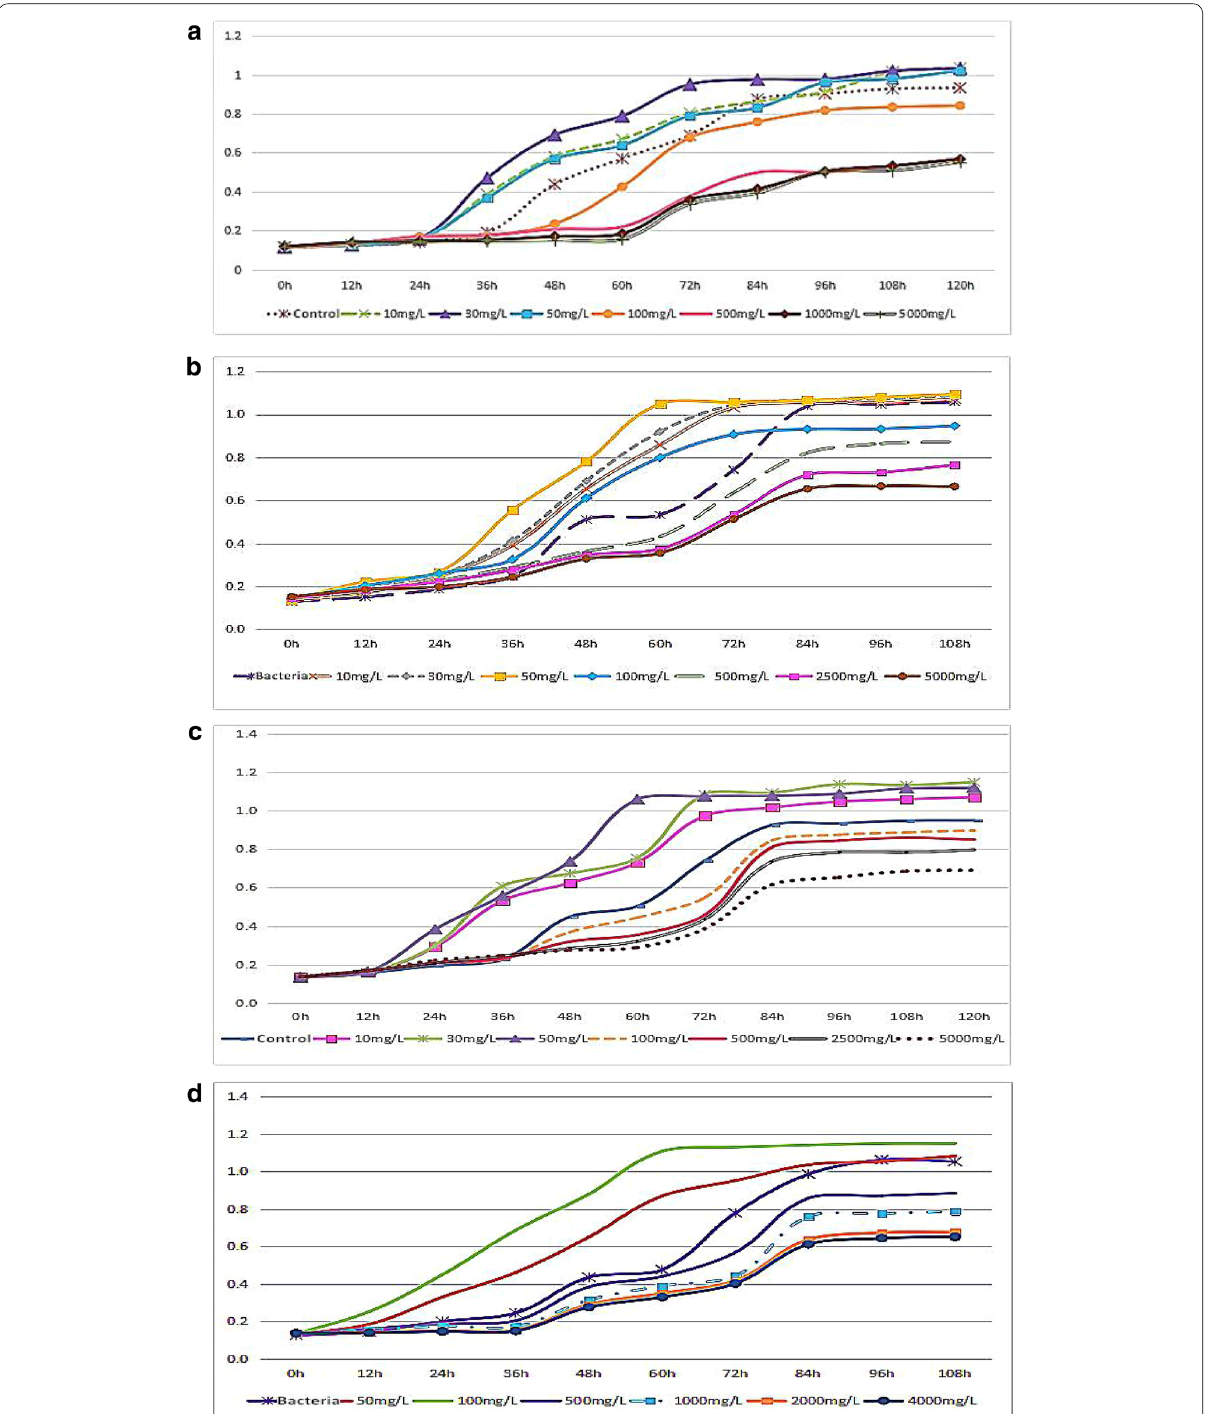
Fig. 1 a – d The effects of Cu 2 + , Fe 2 + , Mn 2 + and Zn 2 + on the proliferation of Pp-7250. Take Zn 2 + as an example. When the concentration of Zn 2 + was 50–100 mg/L, compared with the control group, the delayed period of Pp-7250 multiplication was shortened, and the logarithmic phase was advanced; When the concentration of Zn 2 + was 100 mg/L, the promotion of Pp-7250 was the strongest, the delayed period was shortened by 12 h, and the logarithmic stage was about 24 h in advance; The appropriate concentration of Zn 2 + had a certain promoting effect on Pp-7250. However, when the Zn 2 + concentration was greater than 500 mg/L, there was a certain inhibitory effect on the proliferation of Pp-7250, as the concentration increasing, the inhibitory effect